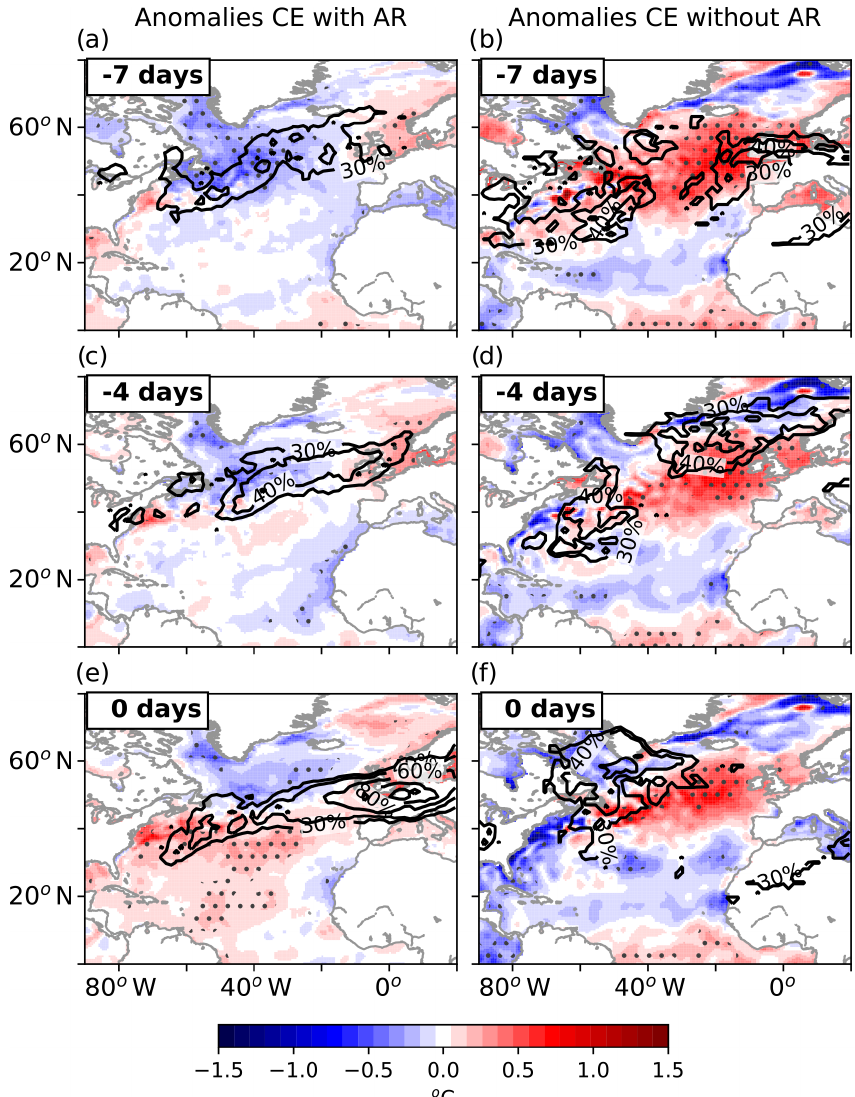
Figure 7. Anomalies in daily mean SSTs (shading) related to CEs with (a, c, e) and CEs without AR association (b, d, f) 7 and 4 days before a CE (Panels a and b ; panels c and d , respectively) and on the day of the event (e, f) . Contours mark regions that are occupied by more than 30% of all ARs in the specific category with contour intervals at 30%, 40%, 60%, 80%, 90%, 99% and 100%. Stippled areas mark regions with a p value below 0.05 derived from a student t test comparing the monthly anomalies of daily mean SST values on the day of events to those throughout the full time